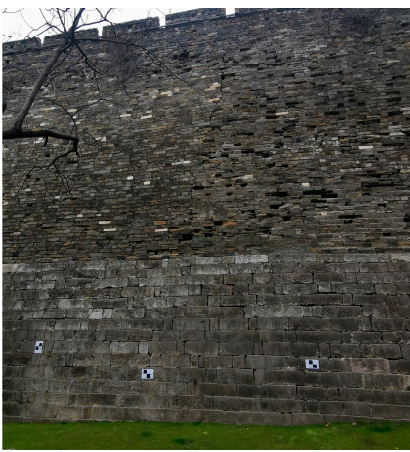
Figure 8. Part of the target points of the surveying area.